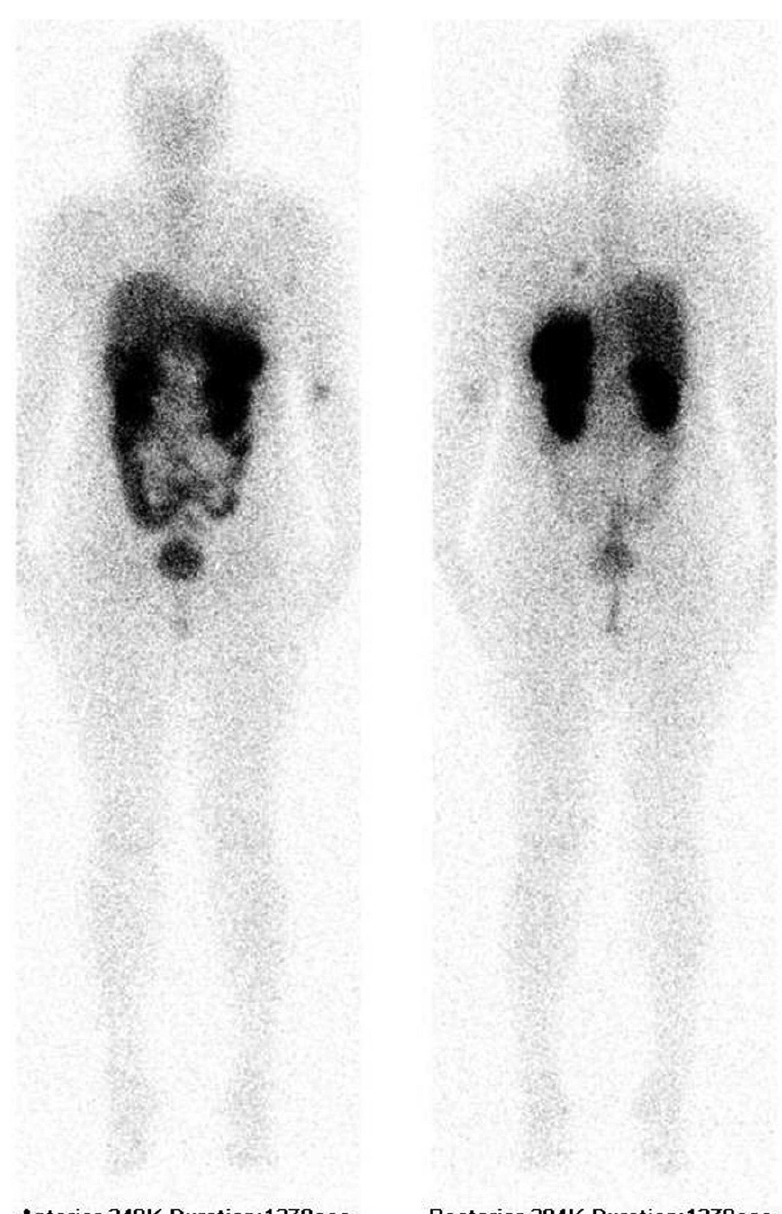
Figure 2 - Somatostatin receptor scintigraphy of the bronchial